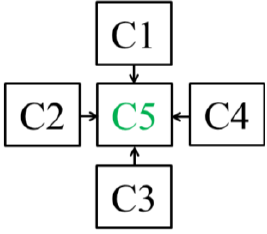
Figure 1. Example of the von Neumann neighborhood considering the nearest neighbors ( C5 with the green color is the center cell, C1, C2, C3, and C4 are the nearest neighbors).